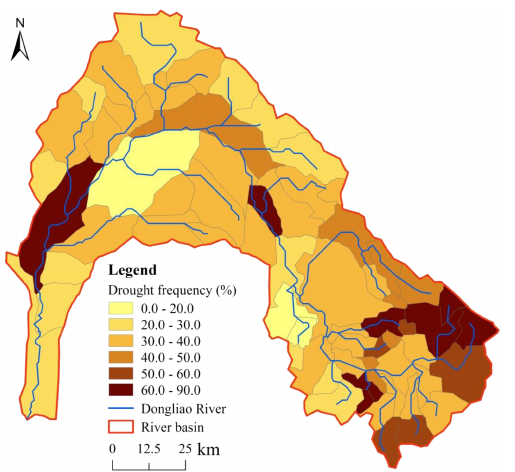
Figure 7. Spatial distribution of drought frequency simulated by the GDAI in the DRB.